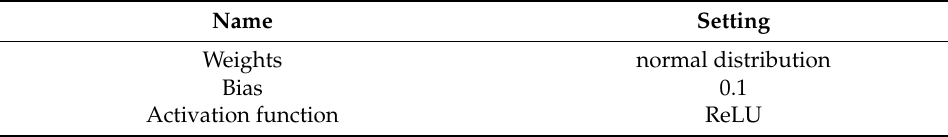
Table 2. Settings of the weights, biases and activation function.